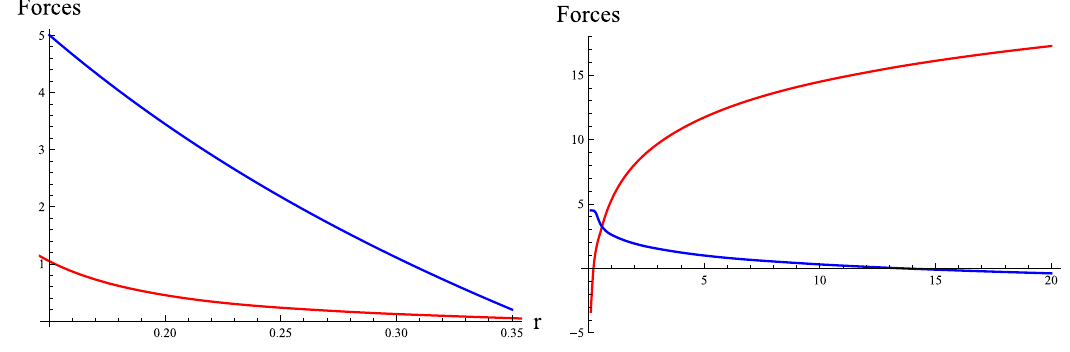
Fig. 13 Plots of F h (blue) and F g (red) versus r for f ( G ) = ξ 1 G + ξ 2 (left) and f ( G ) = φ 7 e φ 7 G + φ 8 + φ 9 (right), w = − 1